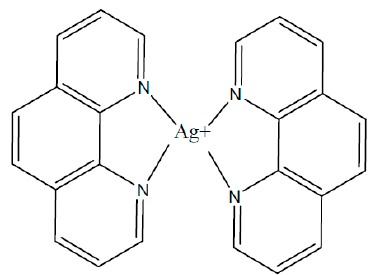
Figure 1. The structure of [Ag(Phen) 2 ] + cation. The nearest neighbors of the silver ion Ag + , N(1), N(2), N(3), and N(4), form distorted tetrahedron, in which the ligand planes are rotated relative to each other, according to experimental data [47,48].